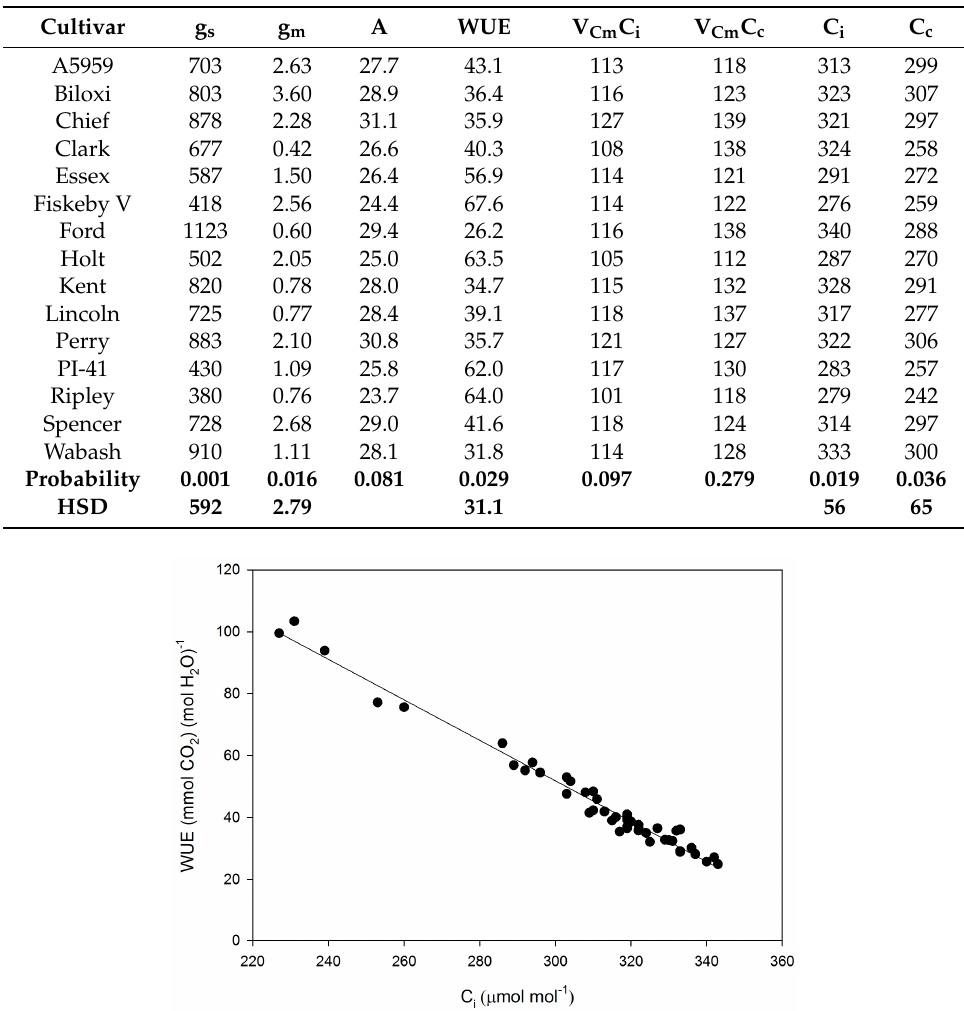
Table 1. Mean leaf gas exchange parameter values of the soybean cultivars tested. Parameters were determined for three or four leaves per cultivar. g s is stomatal conductance in mmol (H 2 O) m − 2 ·s − 1 , g m is mesophyll conductance in mmol (CO 2 ) m − 2 ·s − 1 , A is photosynthetic rate in μ mol (CO 2 ) m − 2 ·s − 1